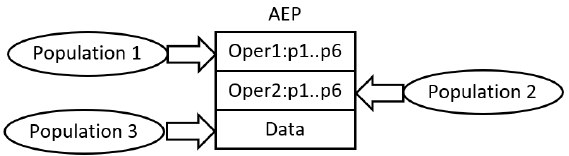
Figure 2. Evolution of AEPs according to